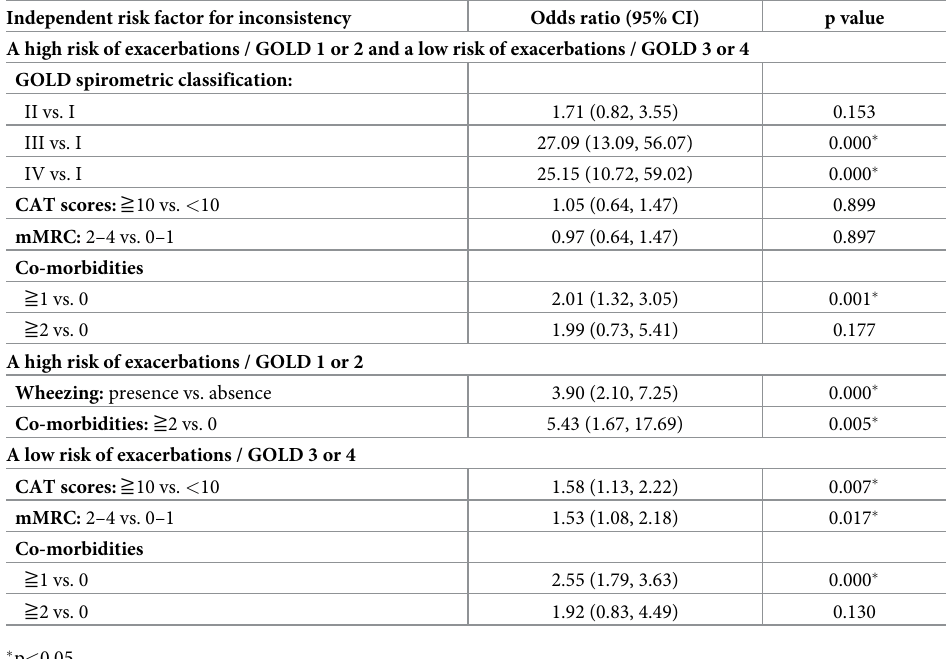
Table 3. Logistic regression analysis of significant factors in univariate analysis for all patients. Independent risk factor for